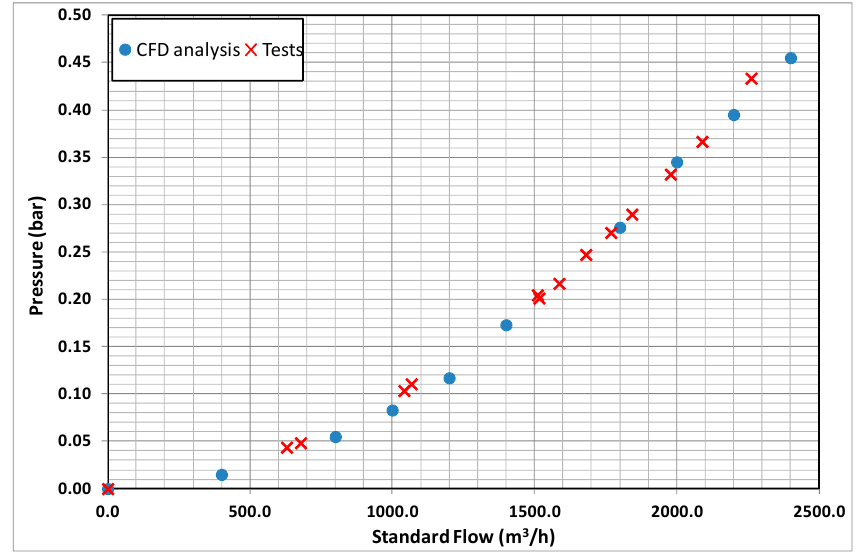
Figure 8. Comparison of the curve of an air valve: experimental data vs. computational fluid dynamics (CFD) analysis. Water 2018 , 10 , x FOR PEER REVIEW